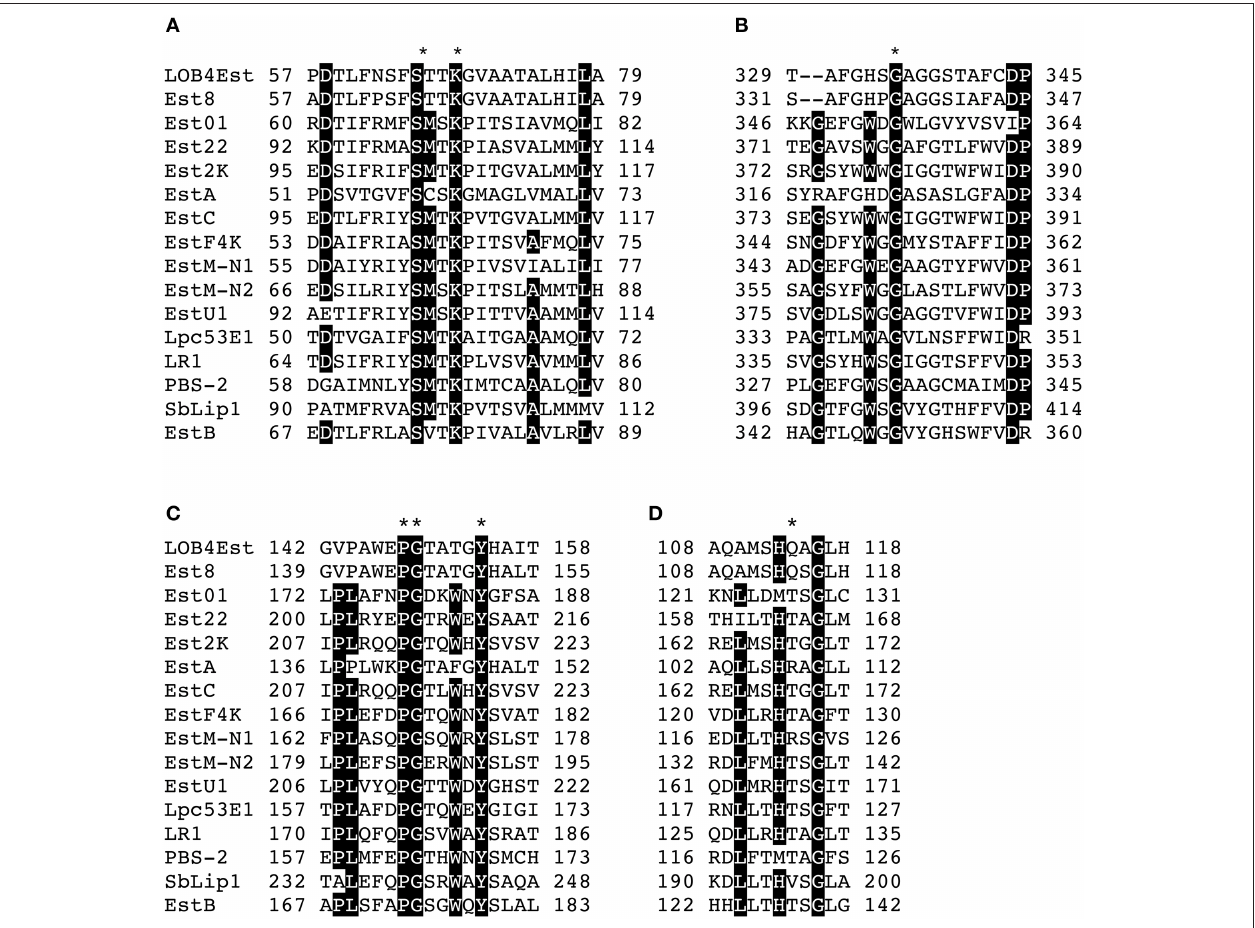
FIGURE 6 | Blocks of the multiple sequence alignment of protein LOB4Est and previously known esterases from family VIII (Arpigny and Jaeger, 1999) showing conserved motifs: (A) S-X-X-K motif, (B) G-X-S-X-G motif, (C) Y-A-N motif, (D) K-T/S-G motif, and L-L-X-H-X-X-G motif. Black background indicate > 80% identity and * indicated identity. Accession number of protein employed were AEM45116.1 for Est8 ( Nacke et al., 2011), AEQ34089.1 for Est01 (Cheng et al., 2014), AGT17593.1 for Est22 (Mokoena et al., 2013), ACX51146.1 for Est2K (Kim et al., 2010), CAD61039.1 fos EstA (Schütte and Fetzner, 2007), ACH88047.1 for EstC (Rashamuse et al., 2009), AEH57832.1 for EstF4K (Ouyang et al., 2013), AEA07653.1 for EstM-N1 (Yu et al., 2011), AEA07655.1 for ESTM-N2 (Yu et al., 2011), AFU54388.1 for EstU1 (Jeon et al., 2011), AFM09717.1 for Lpc53E1 (Selvin et al., 2012), AAZ32715.1 for LR1 (Ranjan et al., 2005), AHL66978.1 for PBS-2 (Kim et al., 2014), AFK83589.1 for SbLip1 (Biver and Vandenbol, 2013), and AAF59826.1 for EstB (Wagner et al.,